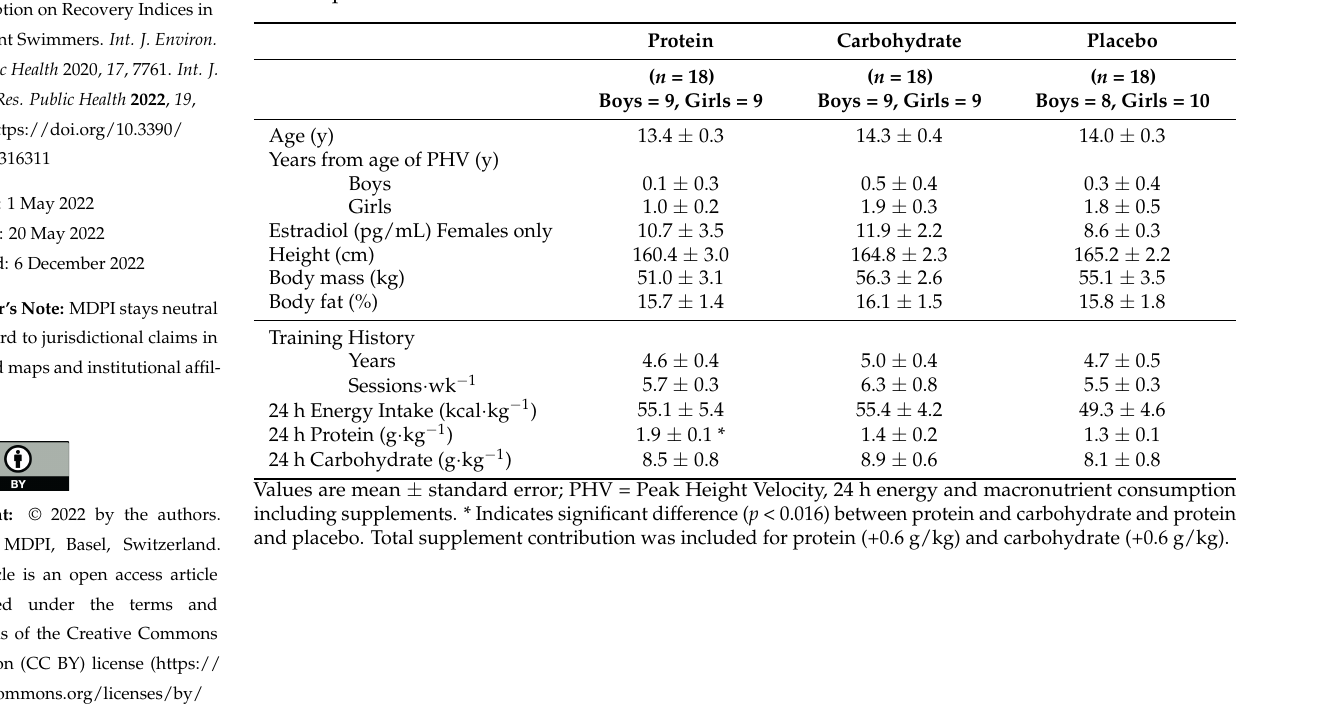
Table 1. Participants’ physical and training characteristics and 24 h energy and macronutrient